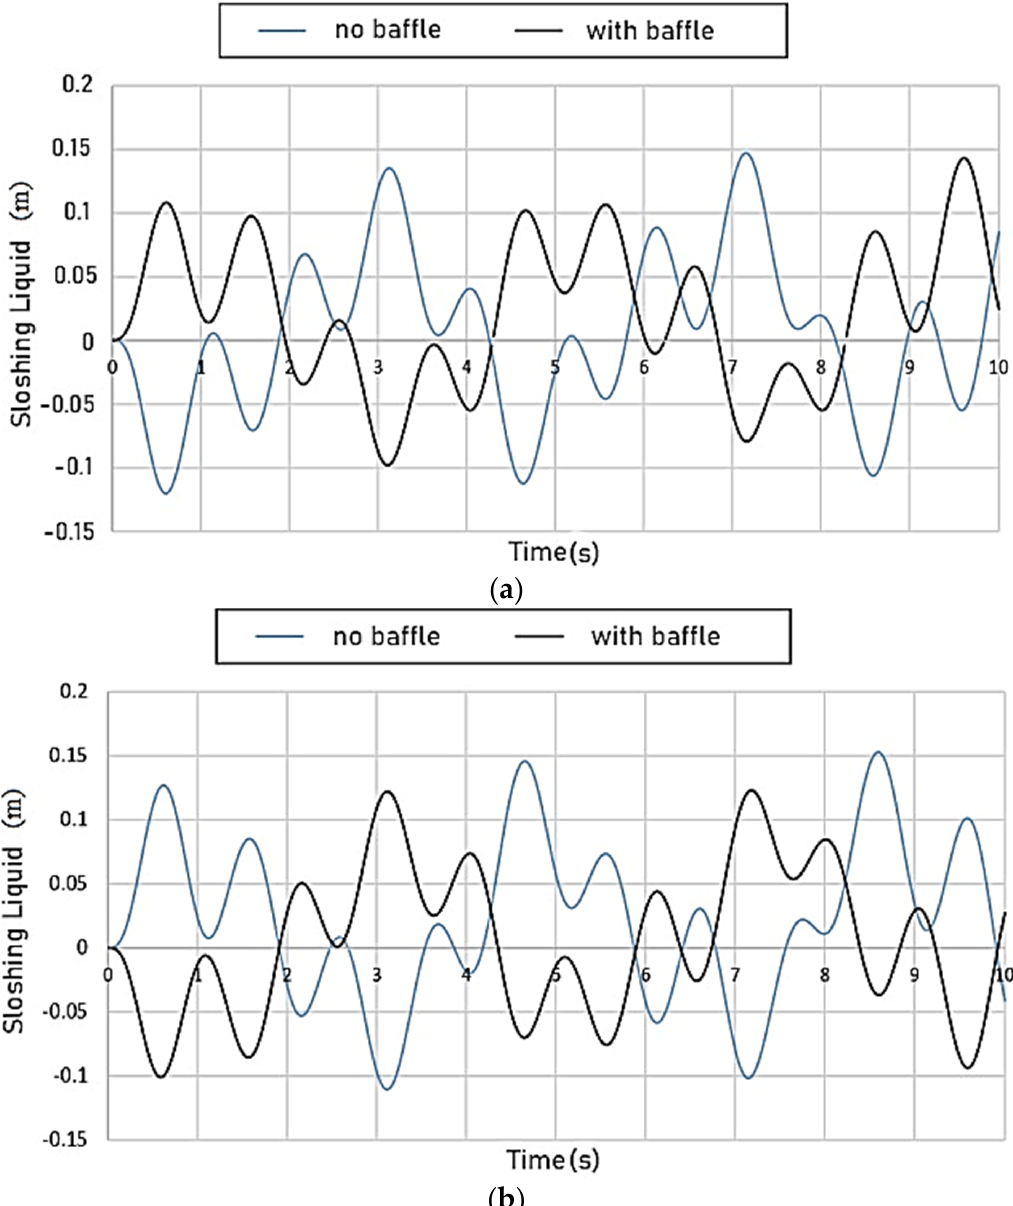
Figure 12. Comparison of sloshing of the fluid surface within the tank with and without a baffle. ( a ) Sloshing of the fluid surface with/no baffle at point 6; ( b ) sloshing of the fluid surface with/without baffle at point 7.